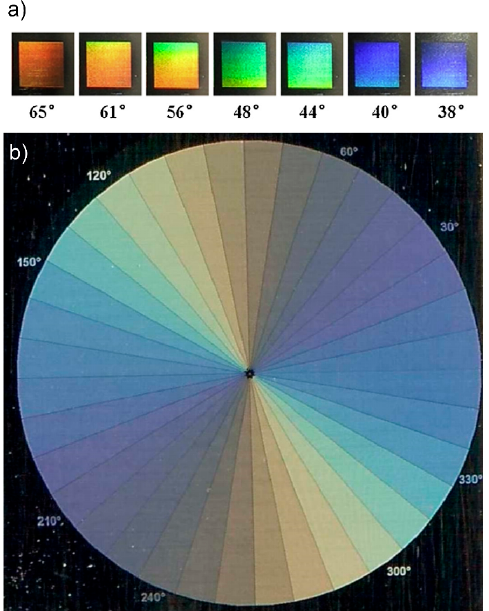
Figure 15. LIPSS-based colorizing of stainless steel: ( a ) variation of structural colors observed at fixed observation angle and different incident angles ranging from 38° to 65° and ( b ) scanned image (1200 dpi) of the sample surface marked by thirty six disc sections characterized by different ripple orientations (from 0° to 350°) but fixed incident and observation angle. ( a ) Reprinted from Yao et al . [97], Copyright 2012, with permission from Elsevier; ( b ) Adapted from Dusser et al . [113], Copyright 2010, with permission from OSA Publishing.